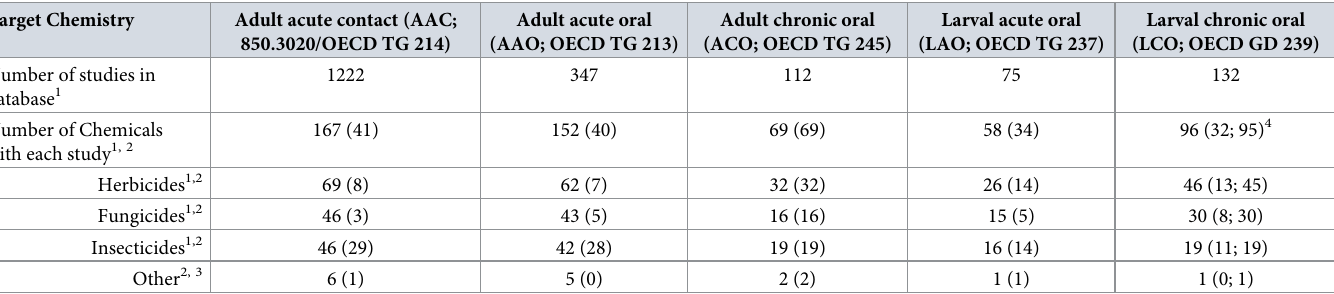
Table 1. Summary of the number of studies and chemicals within each study guideline tested as technical grade active ingredient (TGAI) that were considered before and after data screening. Target